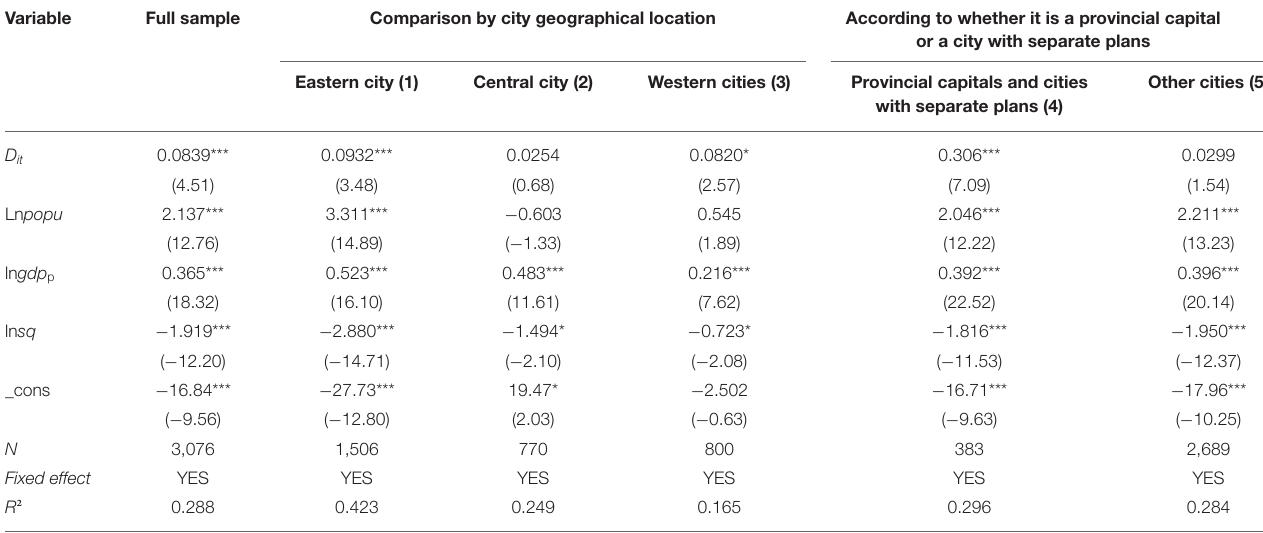
TABLE 8 | Regional heterogeneity evaluation results of the impact of HSR opening on doctor resource density based on multi–time double difference model. Variable